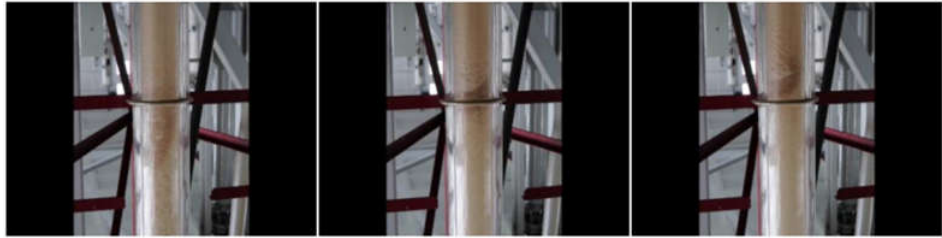
Figure 12. Experimental phenomenon of nitrogen injection of 60 m 3 /h and particle size of 1 mm.